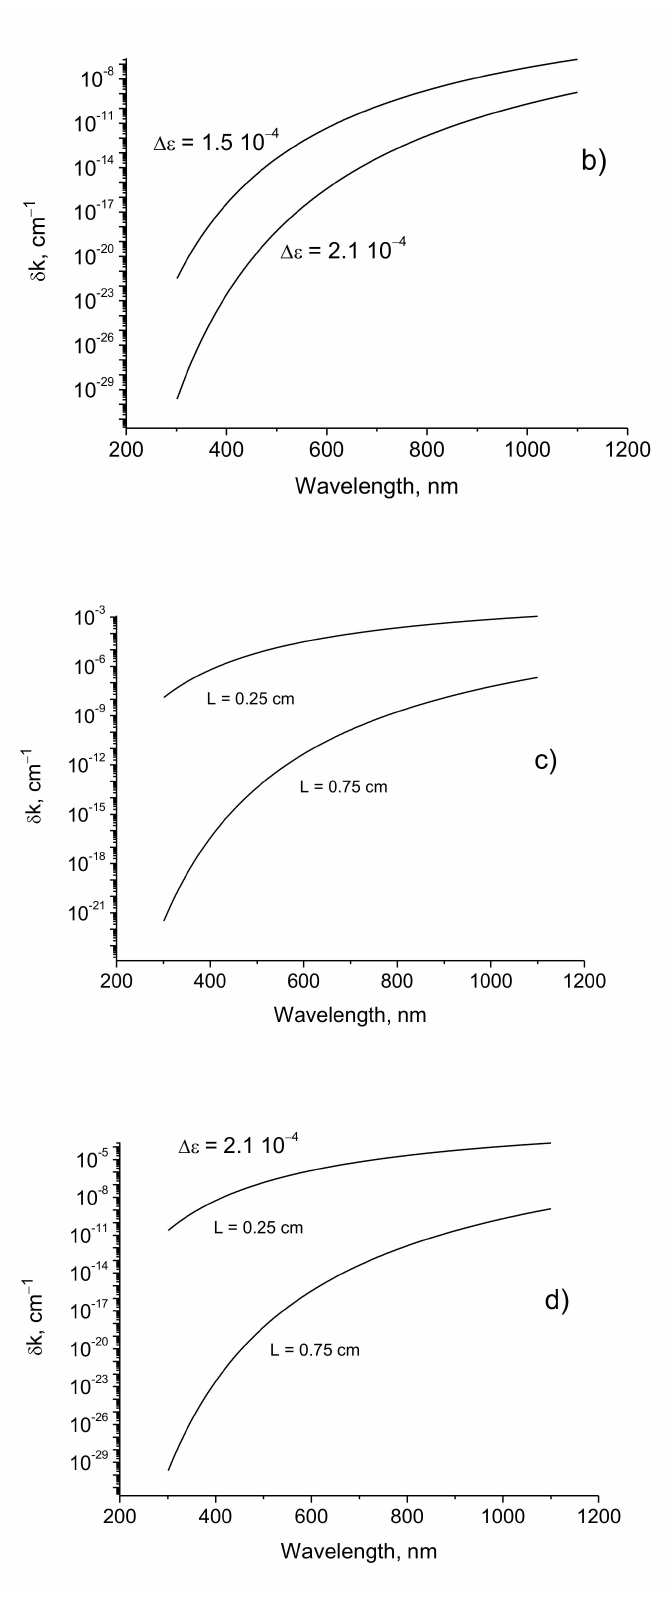
Figure 9. The widths of the transmission spectrum lines as function of radiation